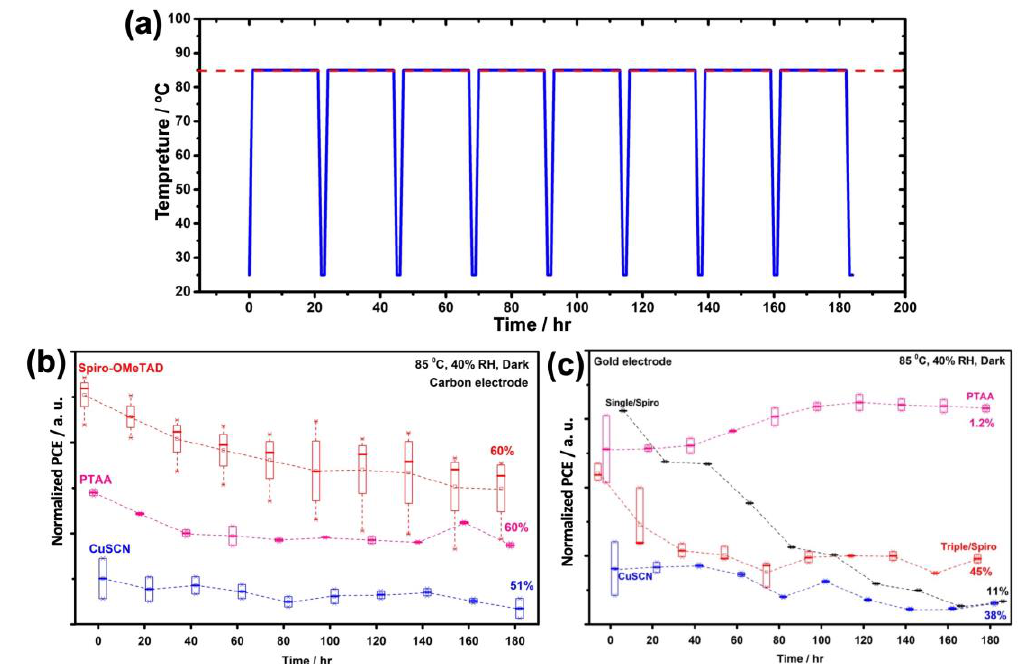
Figure 9. Profile of thermal cycling in stability tests ( a ) . Evaluation of device performance from the stability test of PSCs based on carbon back contact without encapsulation under 85 °C and 40% RH without light soaking ( b ). Evaluation of device performance from the stability test of PSCs based on gold back contact with different HTLs, including PTAA, Spiro-OMeTAD, CuSCN, and without encapsulation under 85 °C and 40% RH without light soaking ( c ); (triple states for triple cation perovskites and single states for single cation perovskites and MAPbI 3 ).